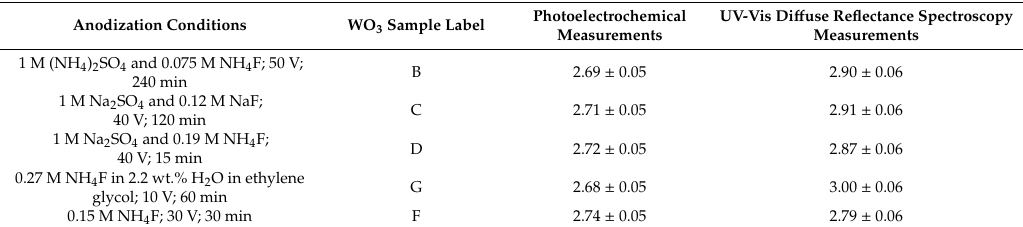
Table 2. Band gap values (eV) of anodic WO 3 layers obtained in various anodizing conditions and then annealed in air at 500 ◦ C for 2 h estimated from IPCE and UV-Vis reflectance